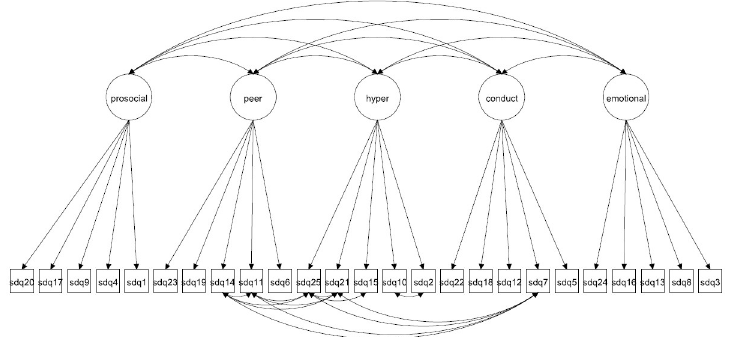
Fig 16. 5-factor model with correlated errors for method effects and minor factors (Model